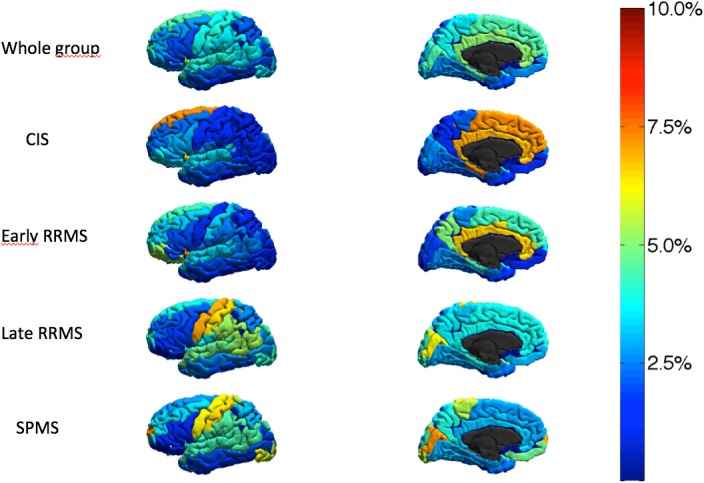
3D Regional map of the cortical thickness change during the 5-year follow up in the whole group and in the different MS subsets.